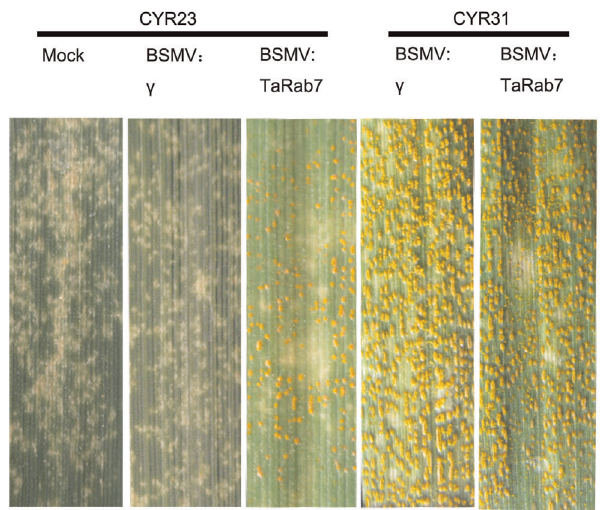
Figure 8. Leaves inoculated with urediospores of avirulent race CYR23 or virulent race CYR31. Leaves inoculated with BSMV: c or BSMV:TaRab7 and urediospores of avirulent race CYR23 or virulent race CYR31. Mock: wheat leaves treated with FES buffer. Typical leaves were photographed at 15 dpi.